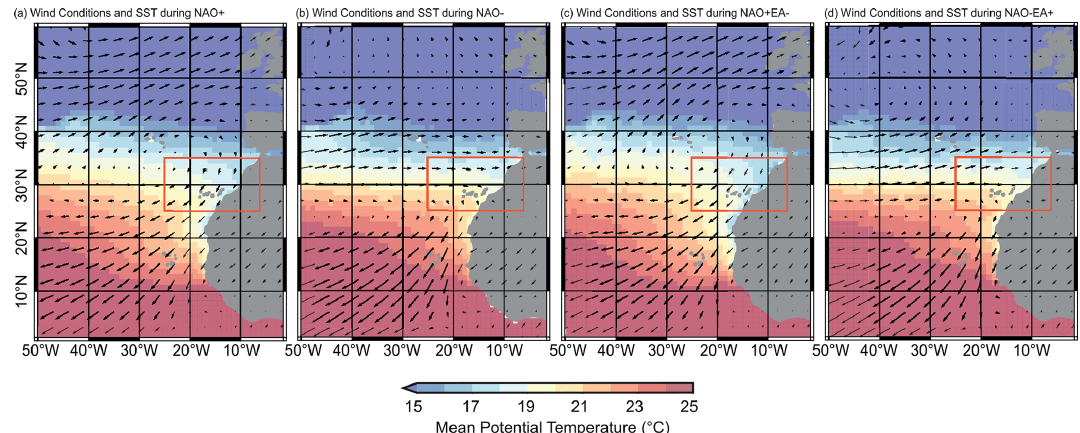
Figure 2. Wind conditions and SST during positive and negative NAO and during combined opposite phases of the NAO and EA. Wind data obtained from ERA5; SST data obtained from Copernicus (for detailed information on NAO + , NAO − , NAO + EA − , and NAO − EA + , see Table 1 and Fig. 4).